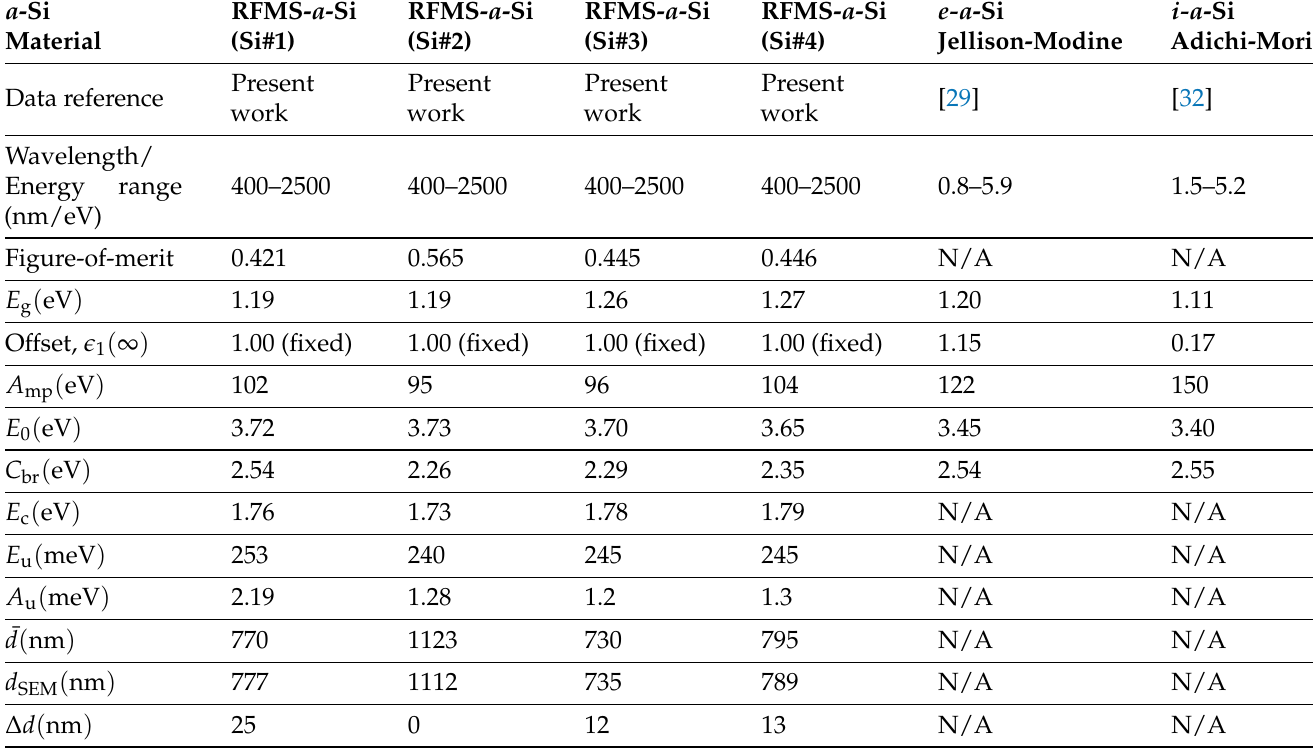
Table 1. Values of all the Tauc–Lorentz–Urbach-Continuous oscillator model parameters for representative RFMS- a -Si thin films, sputtered with high Ar gas pressure. Furthermore, the values of the employed merit function, FOM = 100 × RMSE, for those a -Si samples selected. The Tauc–Lorentz model parameters for implanted a -Si ( i-a -Si) and evaporated a -Si ( e-a -Si), are also listed in the table for the sake of comparison. The values of the Urbach energy and amplitude, E u and A u , respectively, obtained from the previous TLUC-model parameters, are also indicated in the present table. Besides, the values of the geometrical parameters, ¯ d and ∆ d , respectively, are presented in this table. For a greater completeness of the information reported in this work, we have also added, in the columns headed ’Si#3’ and ’Si#4’, respectively, the descriptive results associated to the fits of two more RFMS- a -Si samples